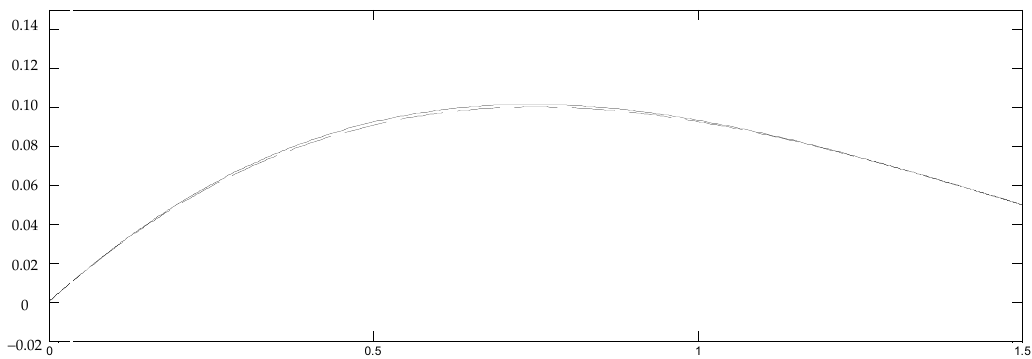
Figure 13. Case 1: Evolution of the robot trajectory in the image plane.